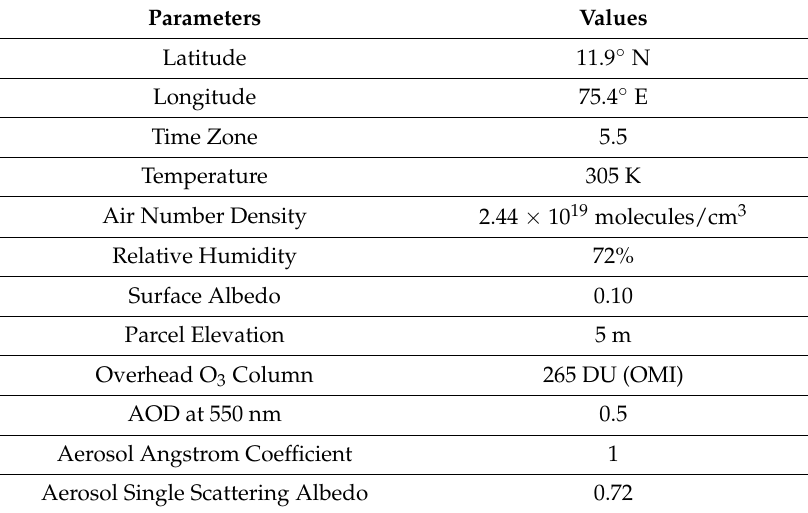
Table 1. Environmental conditions opted for simulations. AOD—aerosol optical